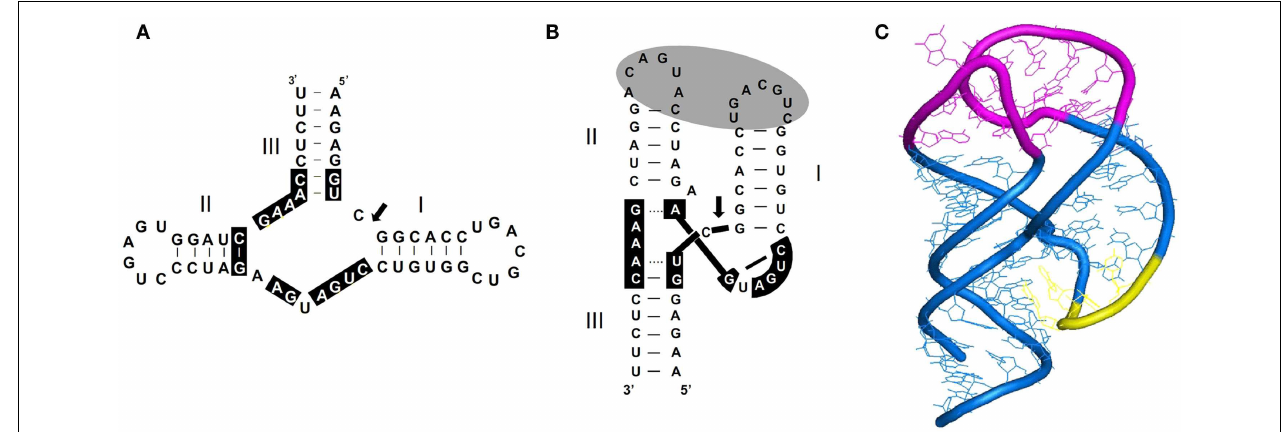
crystallography and NMR data.The proposed tertiary interaction between loops 1 and 2 that facilitates catalytic activity in vivo , is denoted with a gray oval. Dashes indicateWatson–Crick (and wobble) base-pairs and dots non-canonical interactions. (C) Detailed 3D model of this hammerhead structure showing the interactions between loops 1 and 2 (in magenta). Residues in yellow form a local element of higher-order structure (the uridine